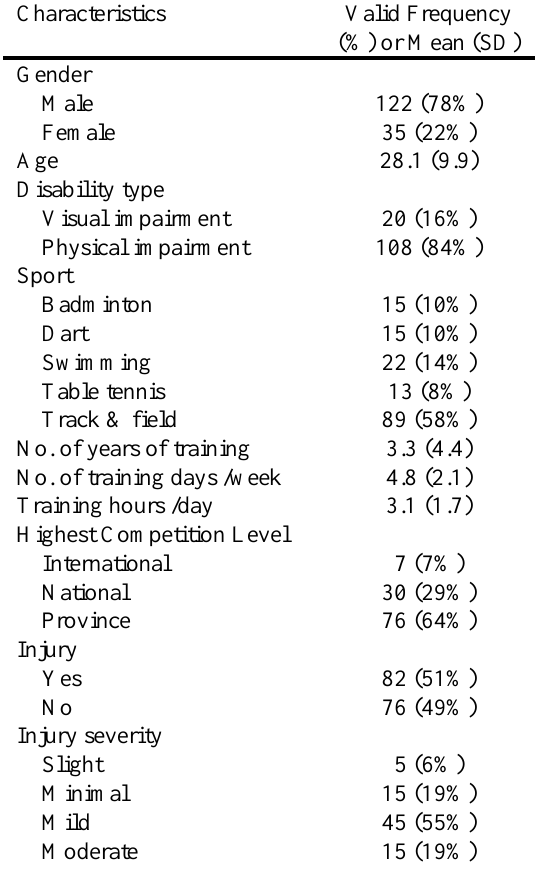
Demographics and other Characteristics of Athletes of the Paralympic Games (n =